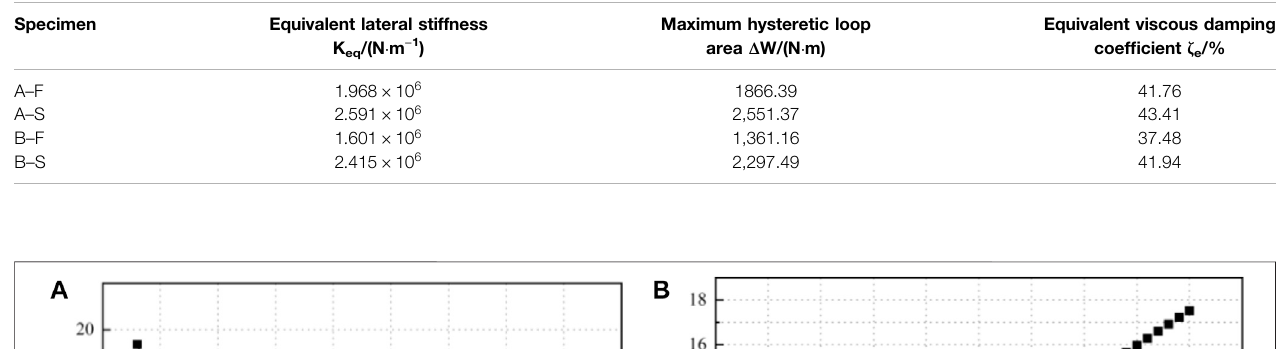
TABLE 5 | Damping performance comparison.